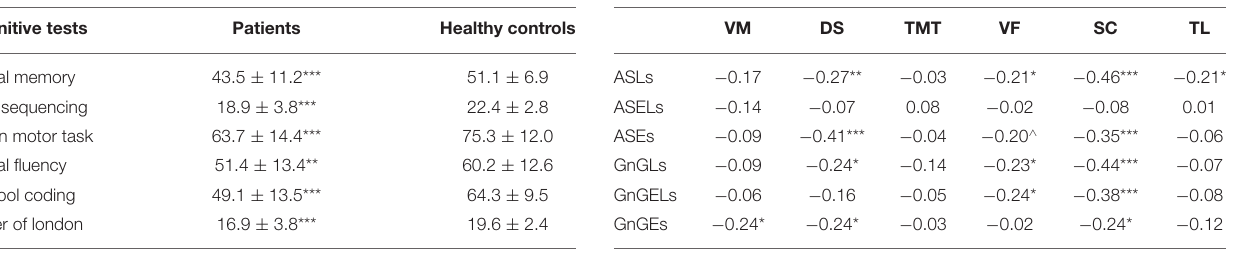
TABLE 4 | Cognitive tests results in patients and healthy control subjects.